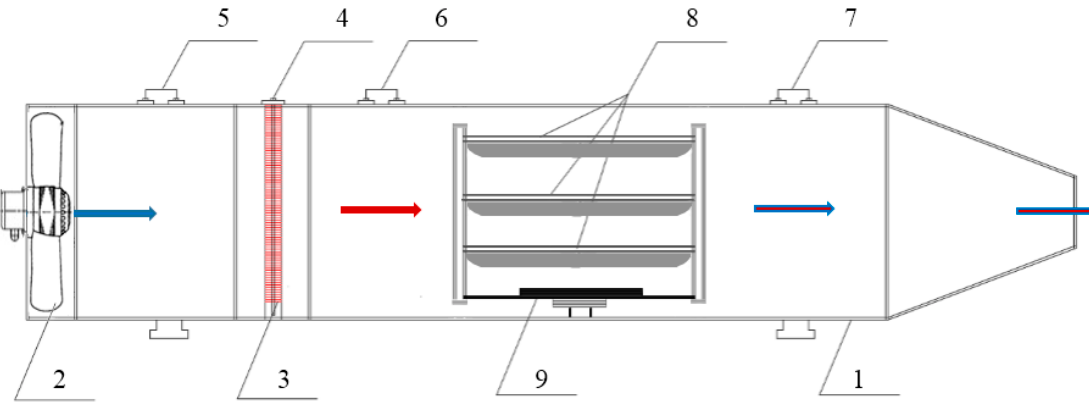
Figure 2. Batch laboratory tray dryer scheme: 1—stainless steel tunnel, 2—axial-flow fan feeding air